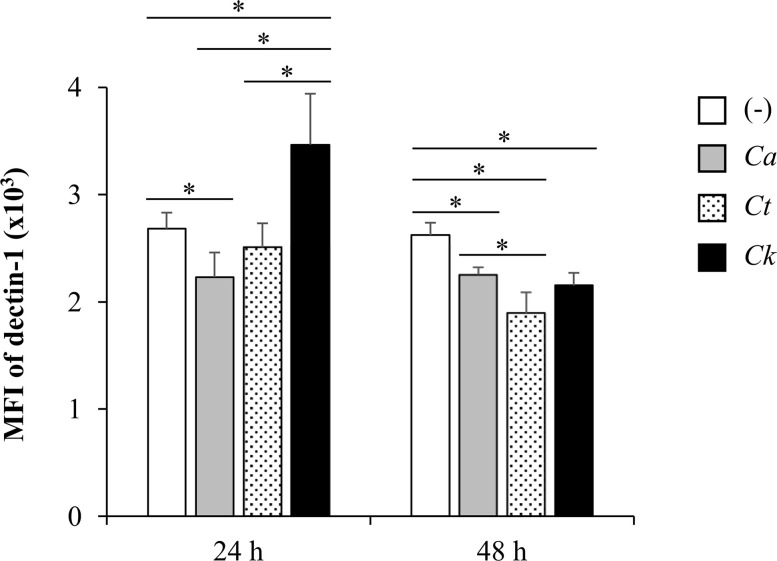
Differential dectin-1 expression on Candida β-glucan-stimulated bone-marrow derived dendritic cells (BMDCs). BMDCs were stimulated with 25 µg/ml of β-glucans isolated from C. albicans, C. tropicalis, and C. krusei for 24 h and 48 h, and the geometric mean fluorescence intensity (MFI) of dectin-1 on CD11c+ cells were determined using histogram analyses. n = 5; data are representative of two independent experiments. *p < 0.05. (-), unstimulated BMDCs; Ca, C. albicans; Ct, C. tropicalis; Ck, C. krusei.